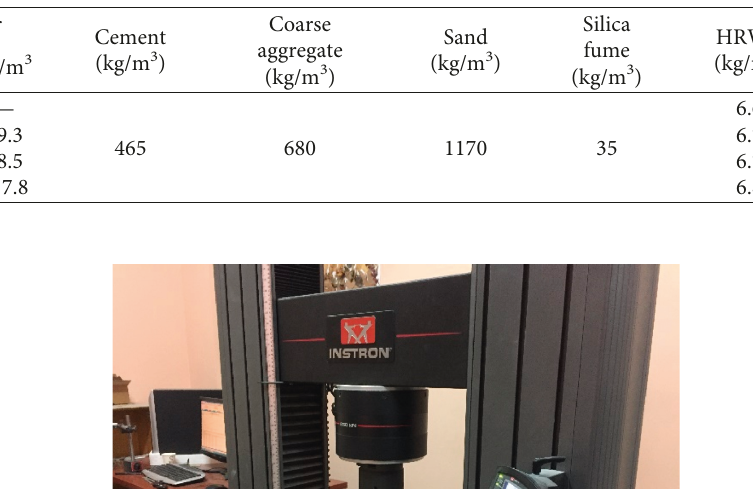
Table 1: Details of concrete mixtures [29].